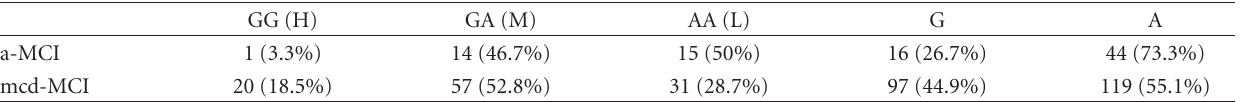
Table 2: Distribution of genotype and allele frequencies of − 1082 (G/A) SNP in amnestic MCI (a-MCI) and multiple cognitive domains MCI patients (mcd-MCI).